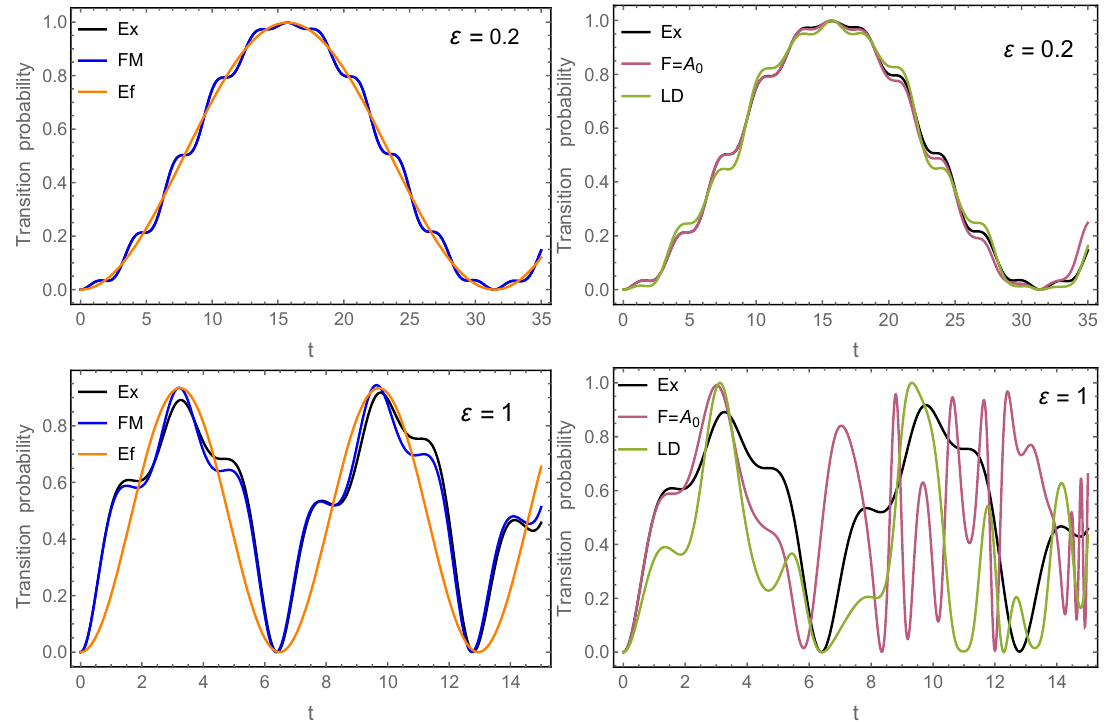
Figure 5. Transition probability obtained with FM (left, blue line) and LD (right, green line) with n = 3 terms in comparison with the exact result for the Bloch–Siegert Hamiltonian with ε = 0.2 (top) and ε = 1 (bottom). Black line corresponds to the exact solution, and orange to the result achieved with the effective Hamiltonian. On the right panels, the results achieved by the algorithm removing the perturbation are also depicted ( F = A 0 ).